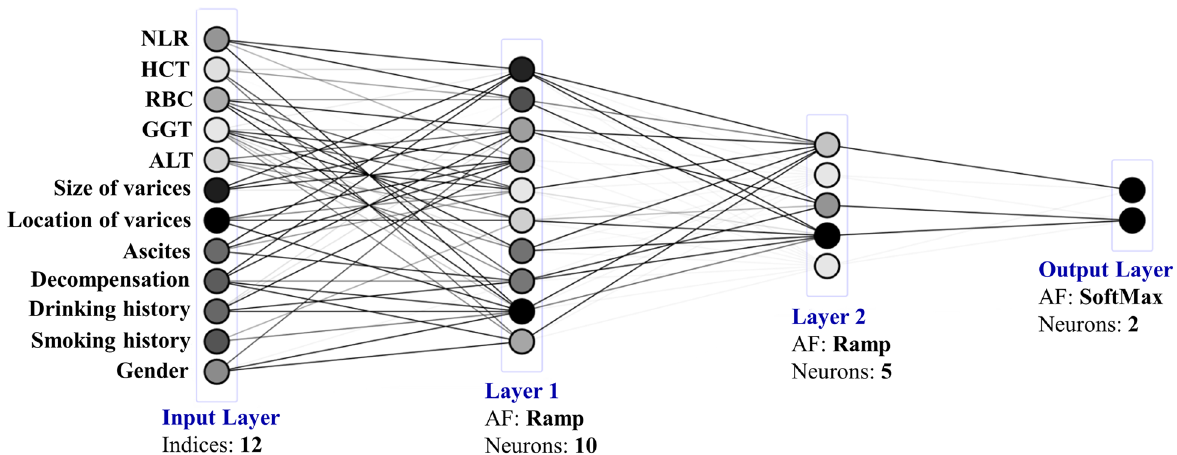
Fig. 2 Artificial neural network model page design according to different conditions of patients